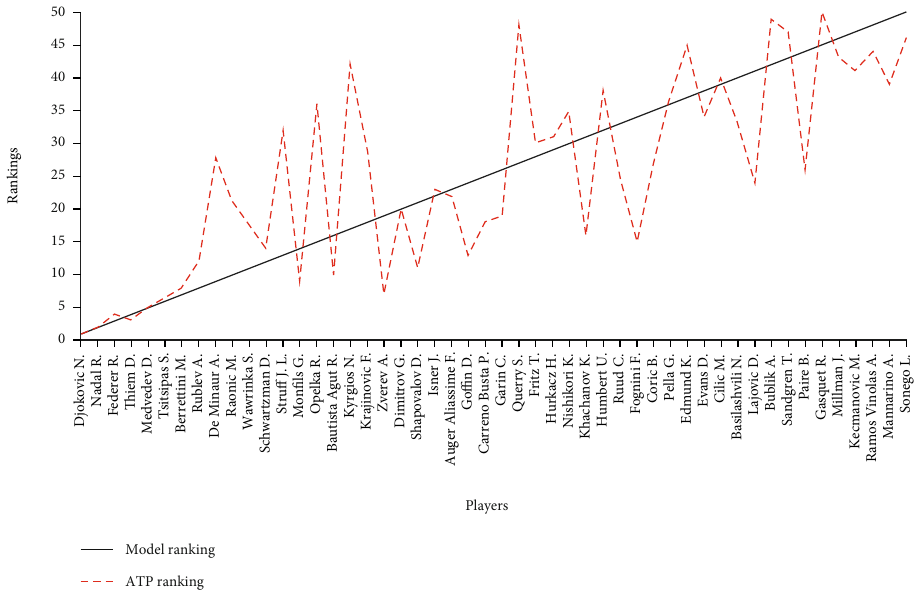
Figure 1: Comparison of model ranking with ATP ranking for top 50 tennis players on all surfaces.